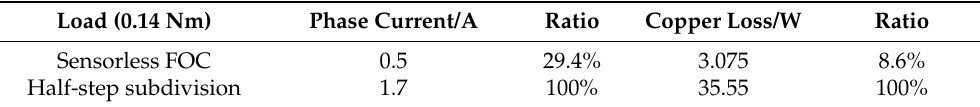
Table 4. Copper loss in loaded